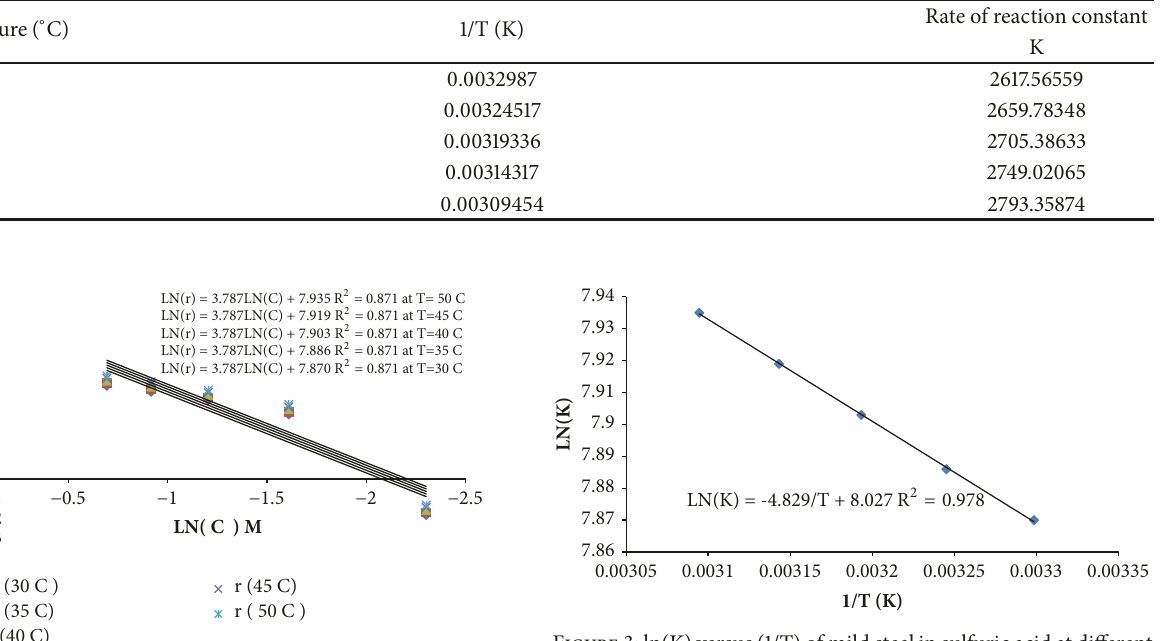
Figure 3: ln(K) versus (1/T) of mild steel in sulfuric acid at different temperature (30-50 ∘